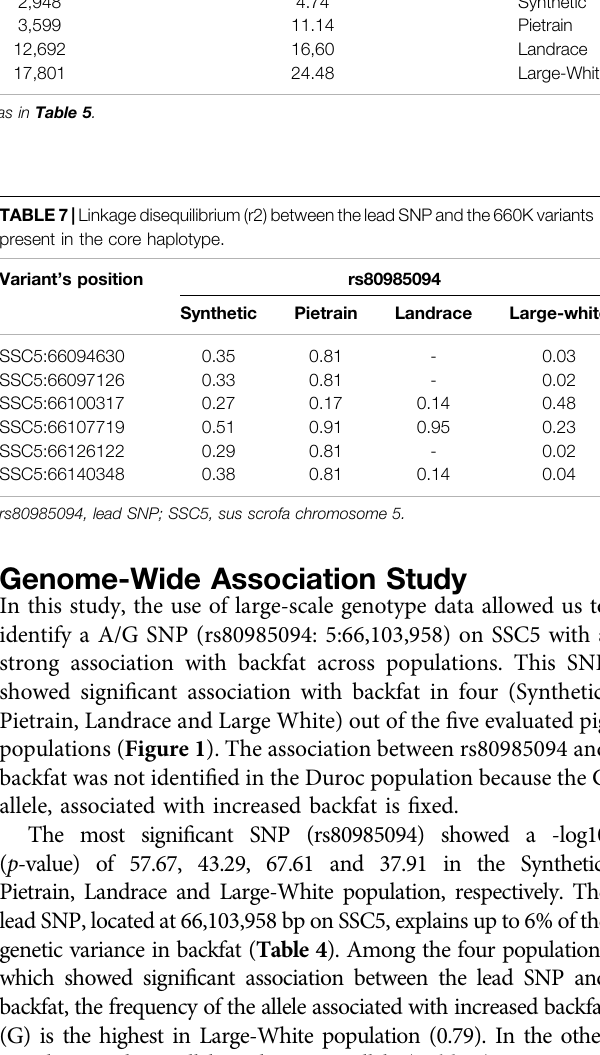
TABLE 6 | Most frequent haplotypes increasing backfat.